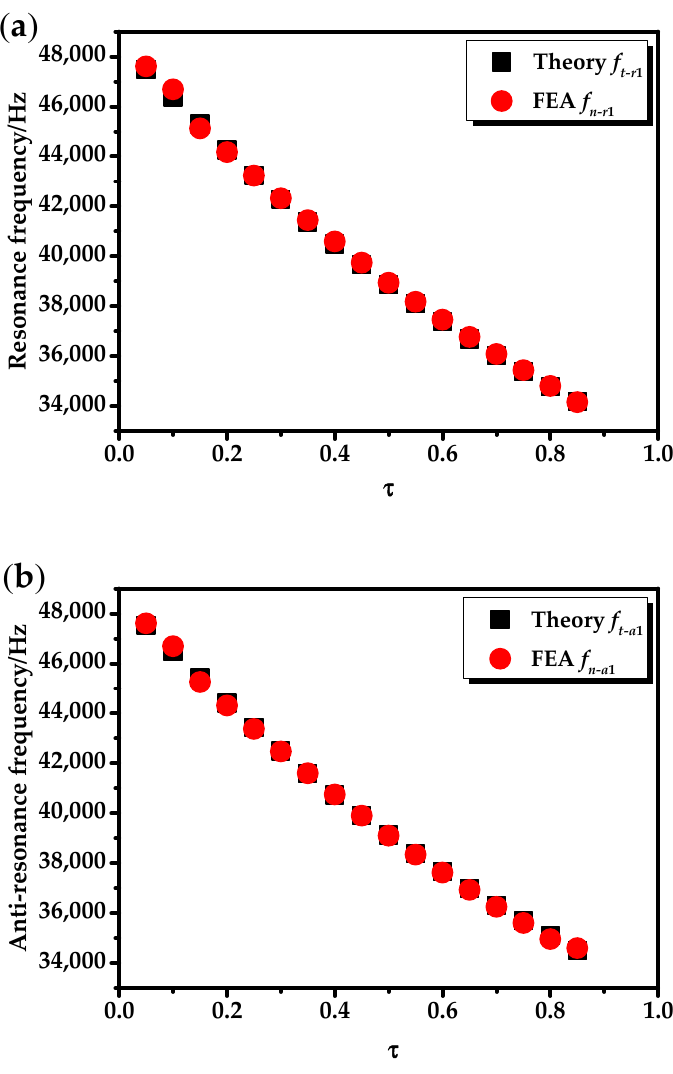
Figure 5. The relationships between the radial resonance, the anti-resonance frequency, and τ at the fundamental mode: ( a ) resonance frequency ( f r 1 ); ( b ) anti-resonance frequency ( f a 1 ).